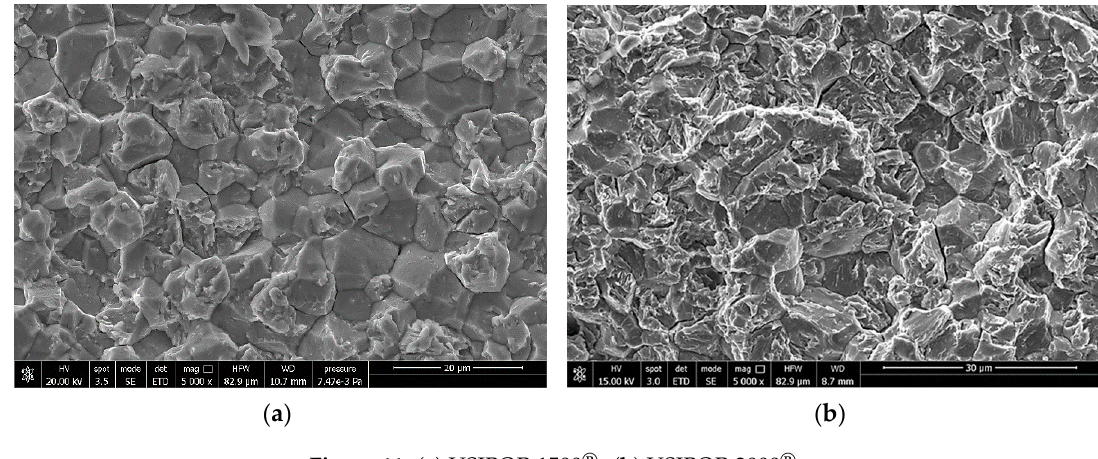
Figure 11. ( a ) USIBOR 1500 ® . ( b ) USIBOR 2000 ® .